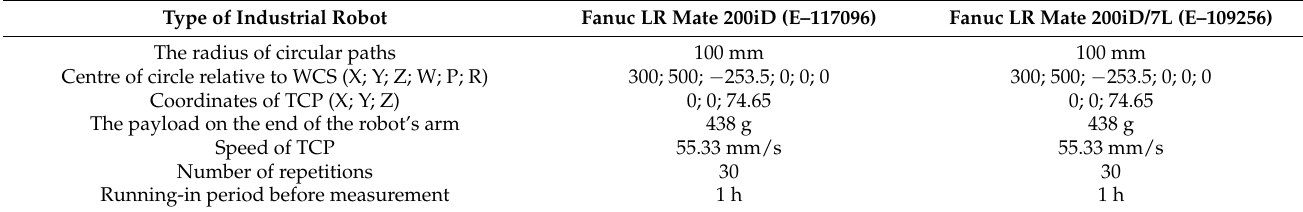
Table 2. Measurement conditions for volumetric analysis.